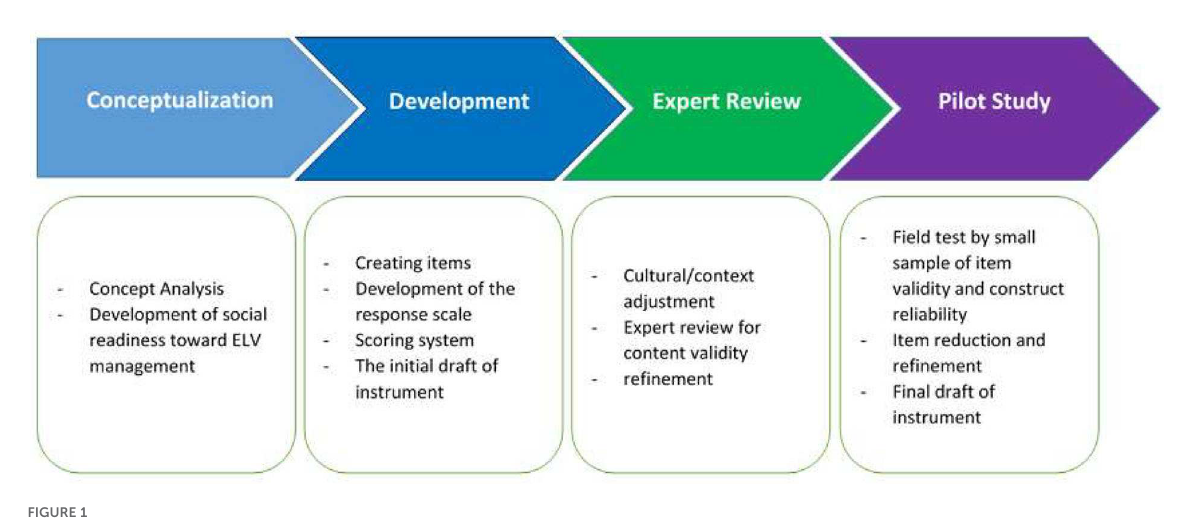
FIGURE1 Instrument development and validation